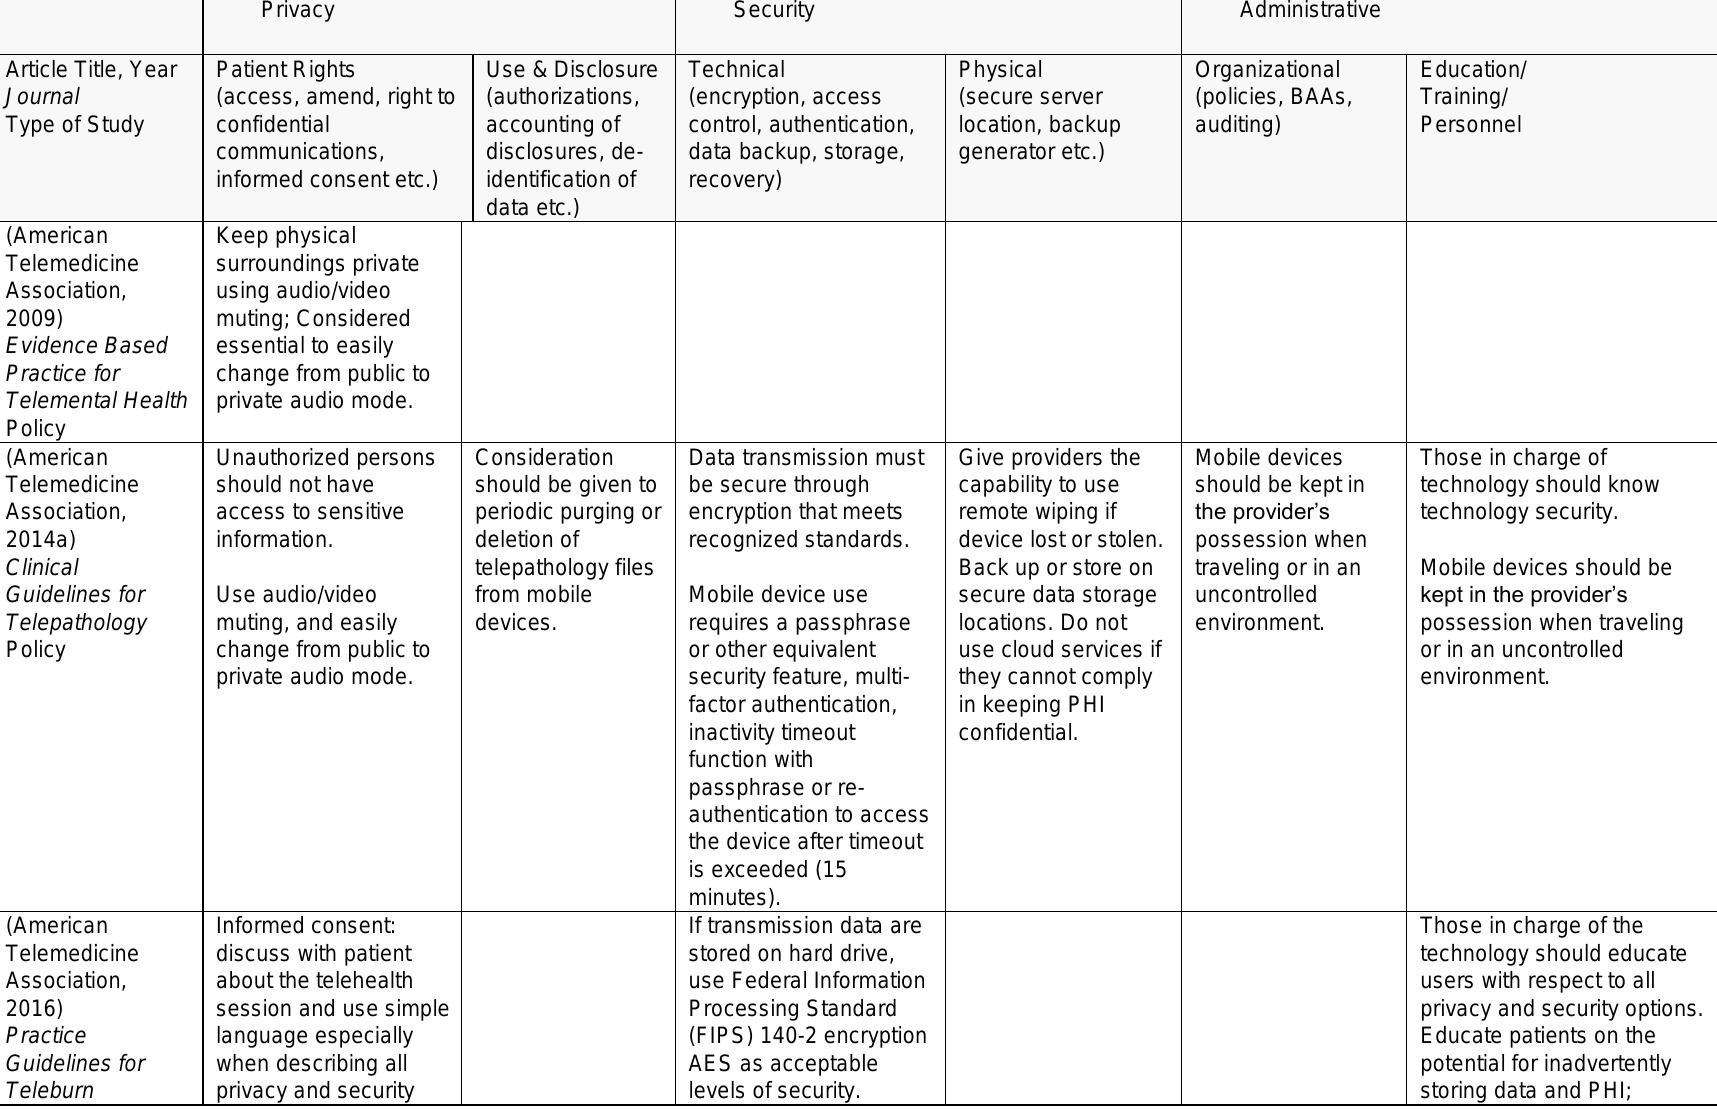
Table 3: Detailed Summary of All Papers for Privacy, Security and Administrative